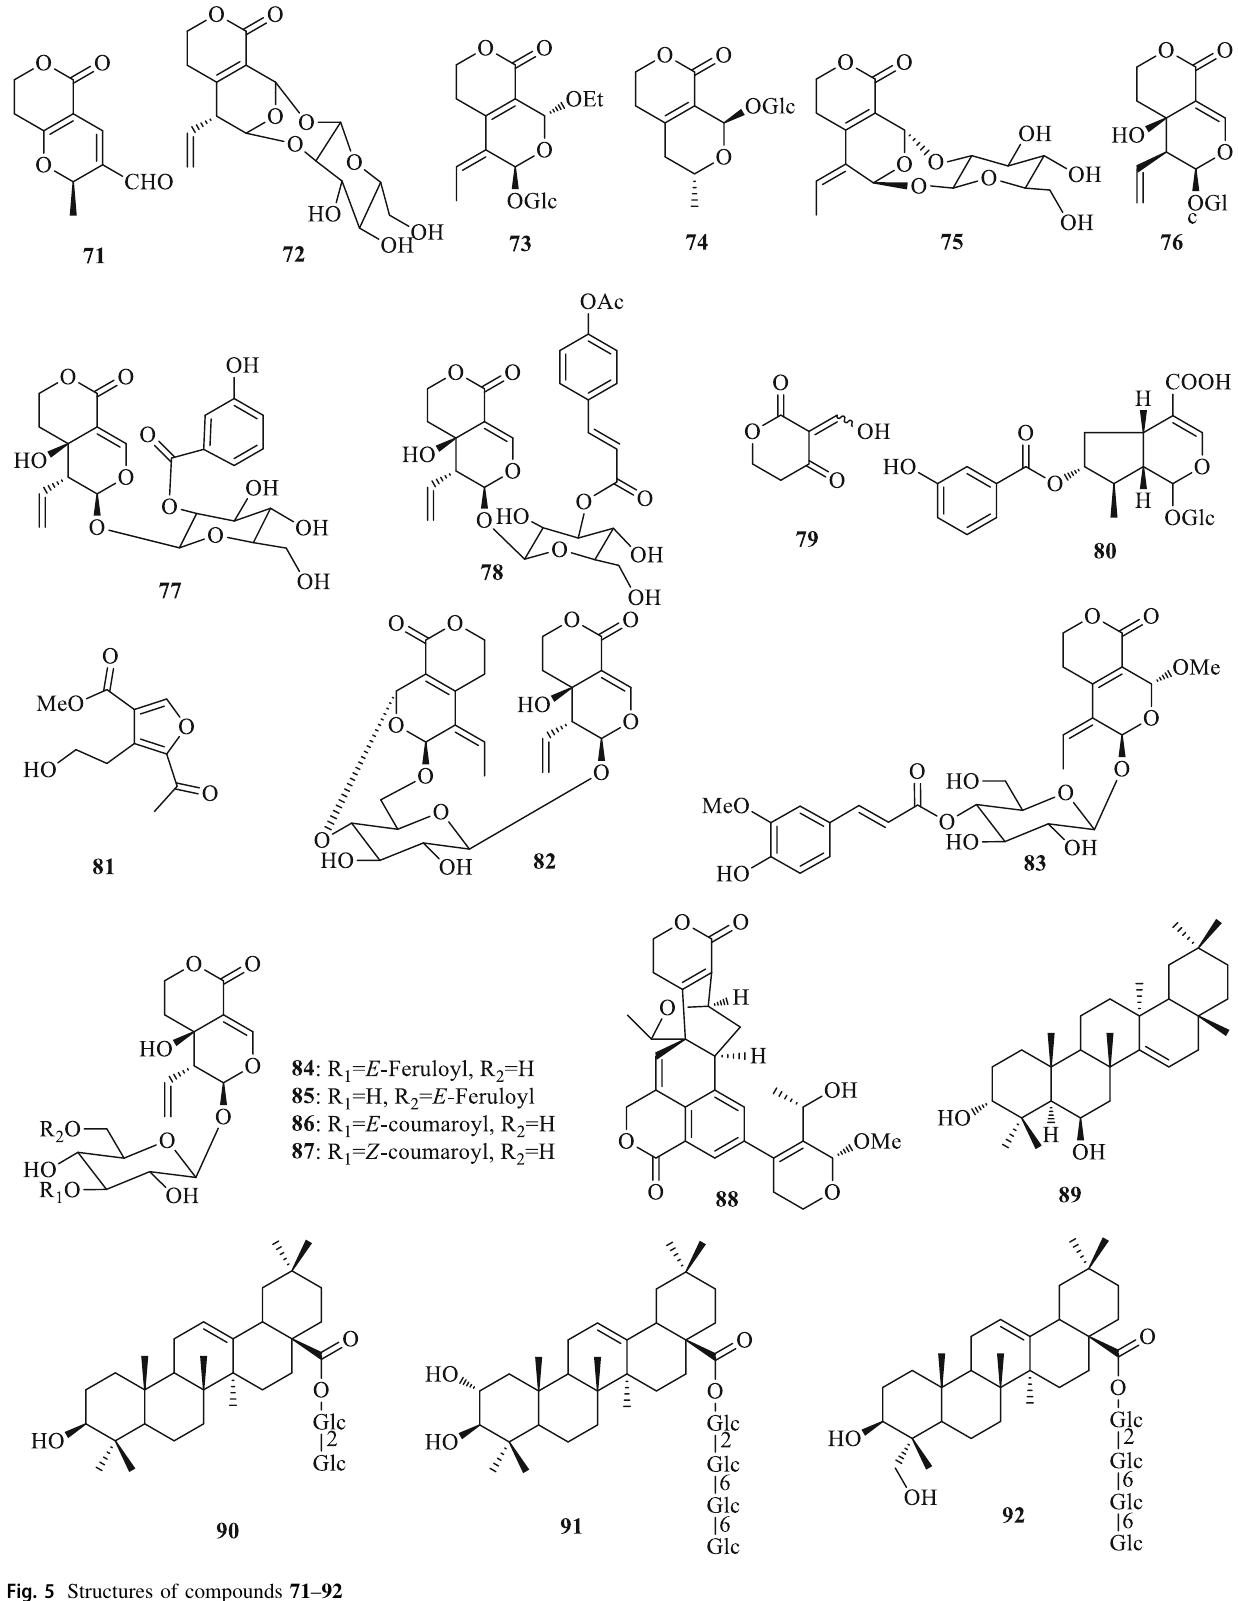
Fig. 5 Structures of compounds 71 –